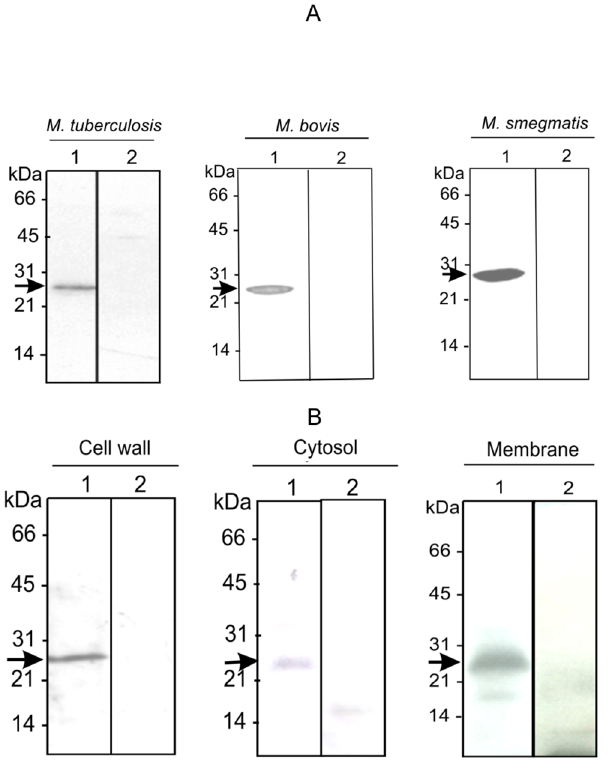
Fig 5. Existence of Cut5b and its homologs in